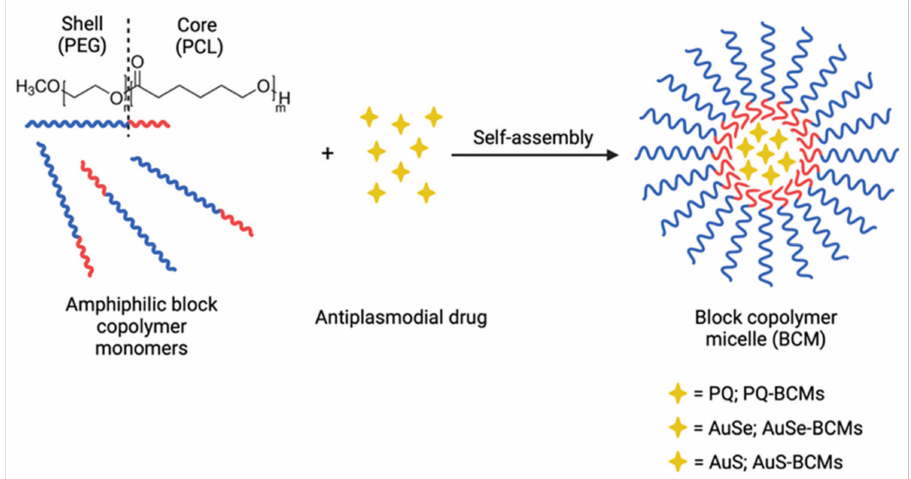
Figure 2. Schematic representation of the synthesis of the micelles with the block copolymer MePEG- b -PCL (in which n = 113 and m = 45) and the antiplasmodial drugs. All micelles were characterized by dynamic light scattering (DLS) to determine the relative hydrodynamic diameter (Dh), polydispersity index (PDI), and zeta potential (Table 1, Figure